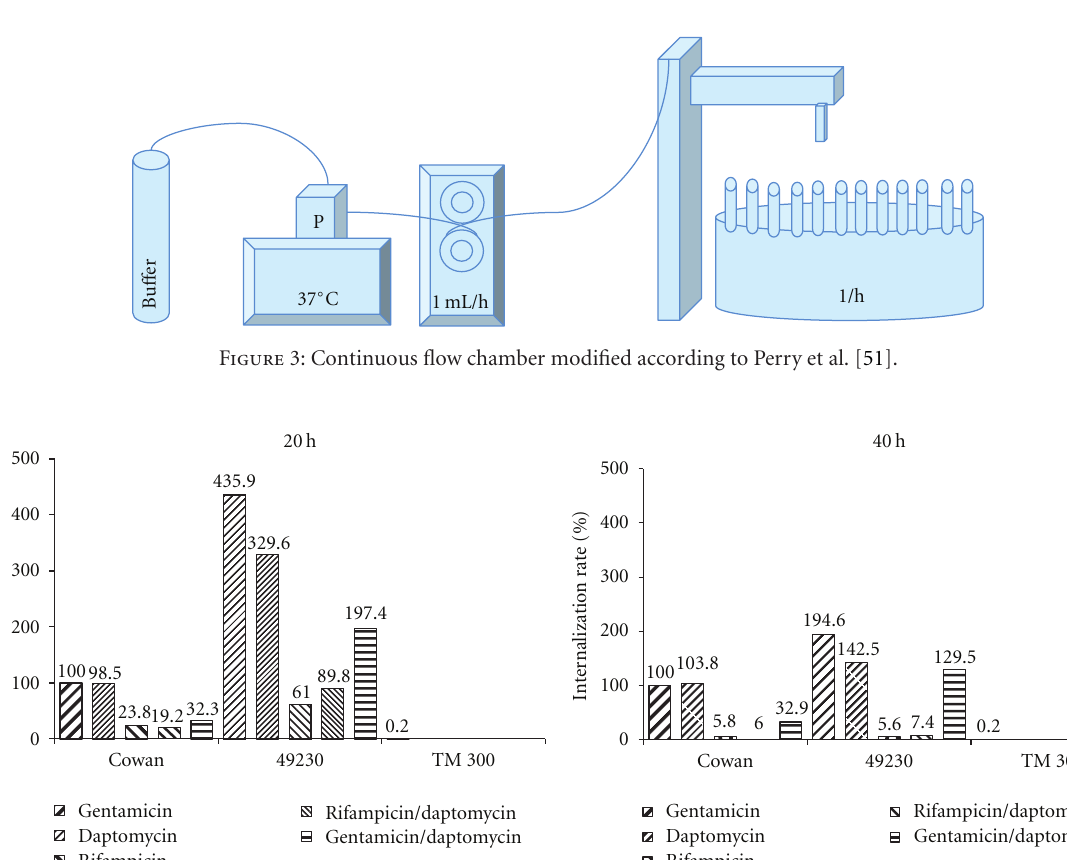
produced correlating defined antibiotic concentrations